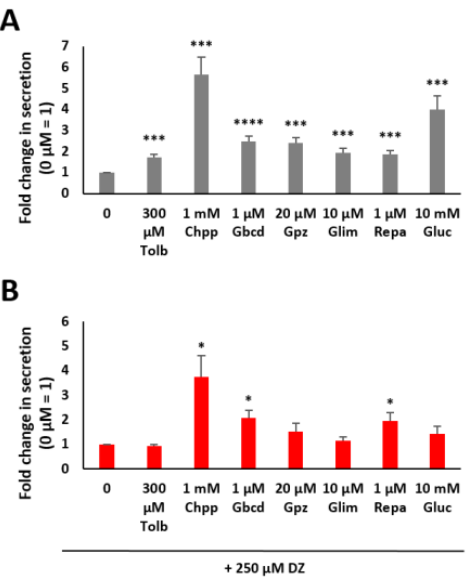
Figure 2. Fold change in insulin secretion as measured by luciferase activity in MIN6 β cells after incubation with tolbutamide (Tolb), chlorpropamide (Chpp), glibenclamide (Gbcd), glipizide (Gpz), glimepiride (Glim), repaglinide (Repa) and glucose (Gluc) ( A ) and incubation after preincubation with 250 µM diazoxide (DZ) ( B ). Fold change in insulin secretion as measured by luciferase activity in MIN6 β cells expressing Ins-GLuc normalized to the activity of 0 mM glucose and expressed as the means ± SEM ( n ≥ 8). * p < 0.05; *** p < 0.001; **** p < 0.0001.